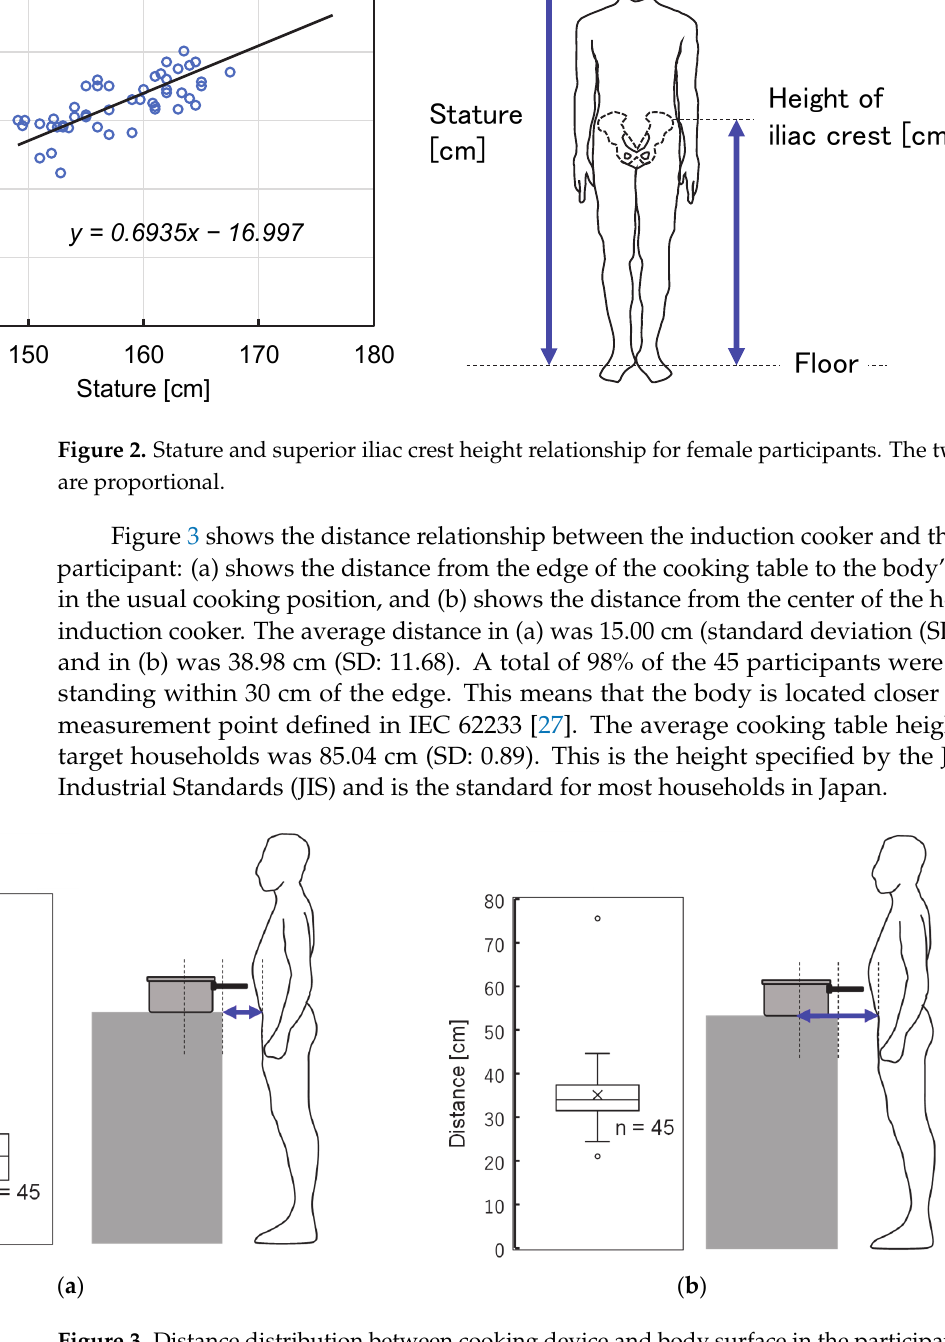
Figure 3. Distance distribution between cooking device and body surface in the participants’ usual posture (cm): ( a ) distance of body surface from cooking table edge and ( b ) distance of body surface from hob. For the center at distance ( a ) the average was 11.2 cm and at distance ( b ) it was 35.0 cm. 3.2. Characteristics of Induction Cookers and Distribution of Measured Magnetic Fields The distribution of the fundamental frequency is shown in Figure 4. The fundamental frequency ranged from 20 k to 30 kHz, the optimum frequency for heating iron and stainless steel. However, heating by equipment compatible with aluminum pots used a frequency of 75 kHz. The highest value for the measured magnetic flux density was obtained at a distance closest to the enclosure in the horizontal plane of the cooking table (measurement grid: d = 0, h = 0), with an average value of 3.864 μ T (SD: 3.311). Table 1 shows the measured magnetic flux densities distribution for the measurement grid.